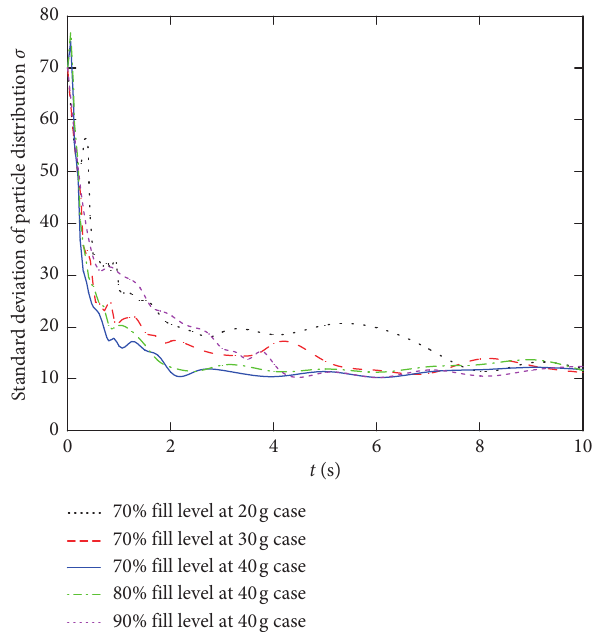
Figure 13: The standard deviation of particle distribution under five different